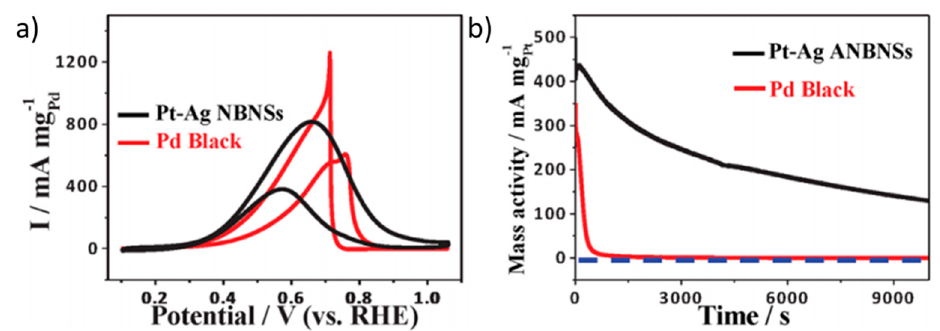
Figure 5. ( a ) Cyclic voltammetry, at 50 mV s − 1 , of Pt-Ag nanoballoon nanoassemblies and Pd black, and ( b ) chronoamperometry at 0.56 V vs. RHE on the two catalysts, in 1 M HCOOK + 1 M KOH. Reprinted with permission from Ref. [65].